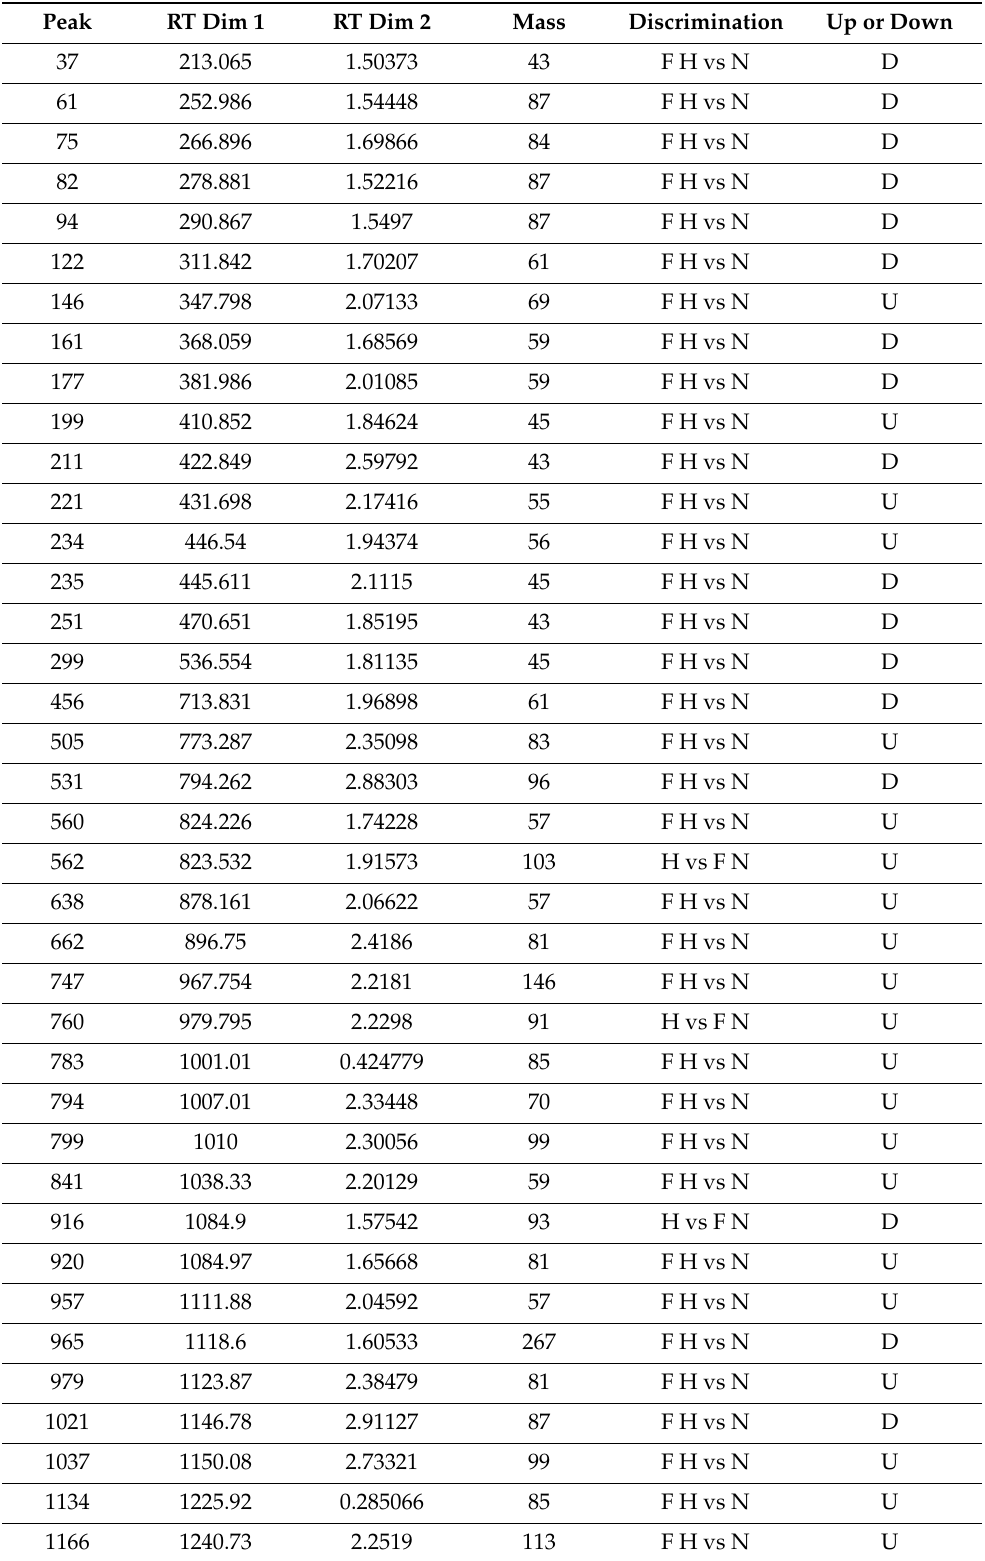
Table A1. Discriminative peaks from three PLS-Da models with peak in order of first dimension retention time on non-polar column (RT Dim 1) with addition of second dimension retention time on mid-polar column (RT Dim